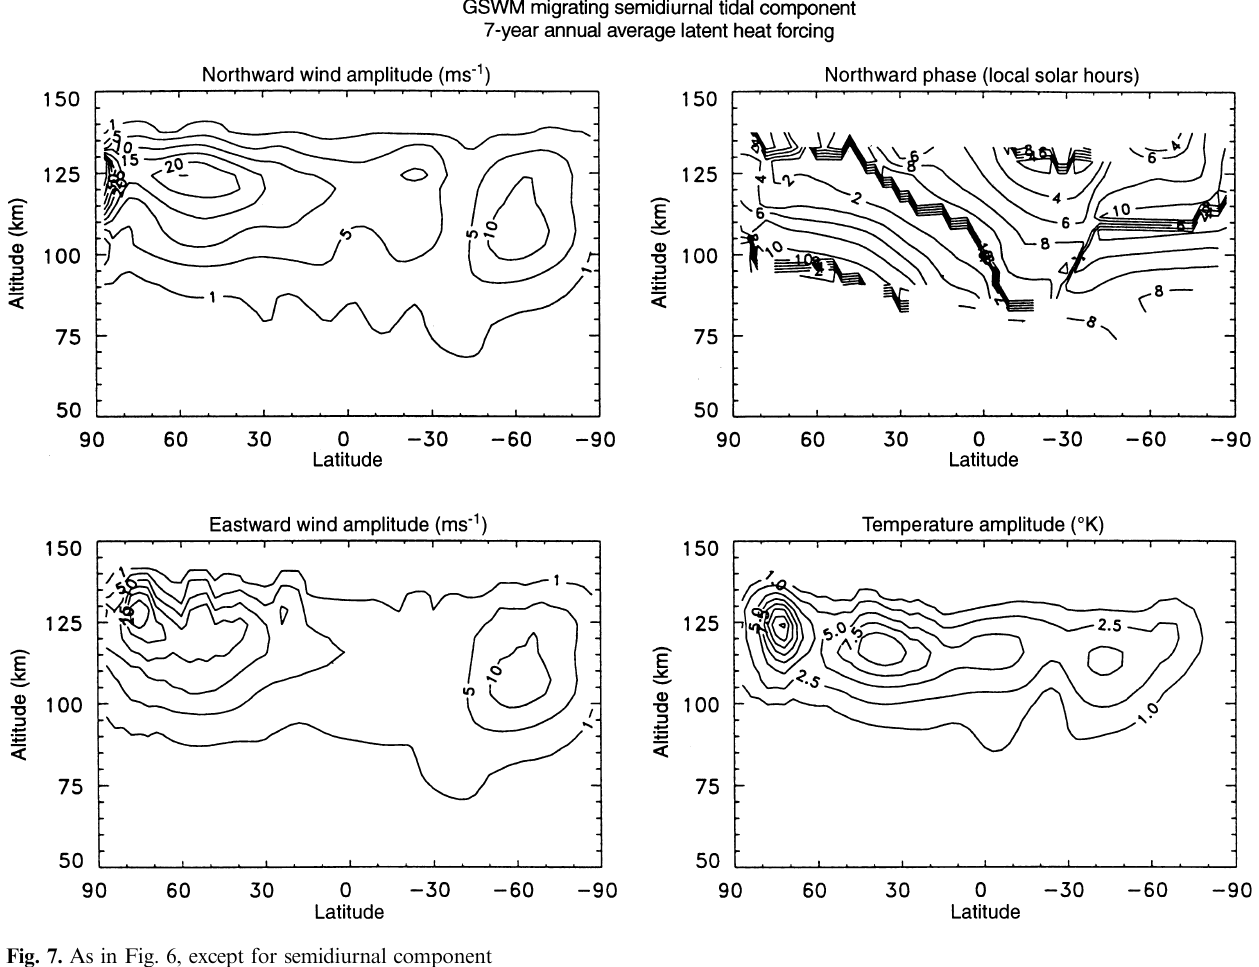
Fig. 7. As in Fig. 6, except for